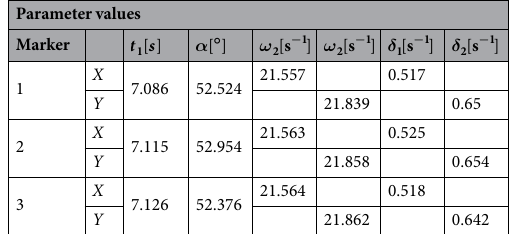
Table 1. Values of the calculation and system parameters obtained numerically based on the analytical procedure developed.